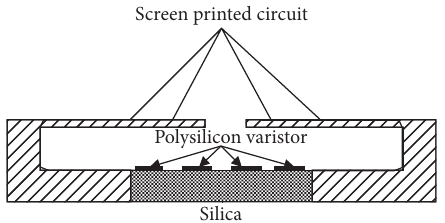
Figure 1: Schematic diagram of silicon piezoresistive pressure sensor.